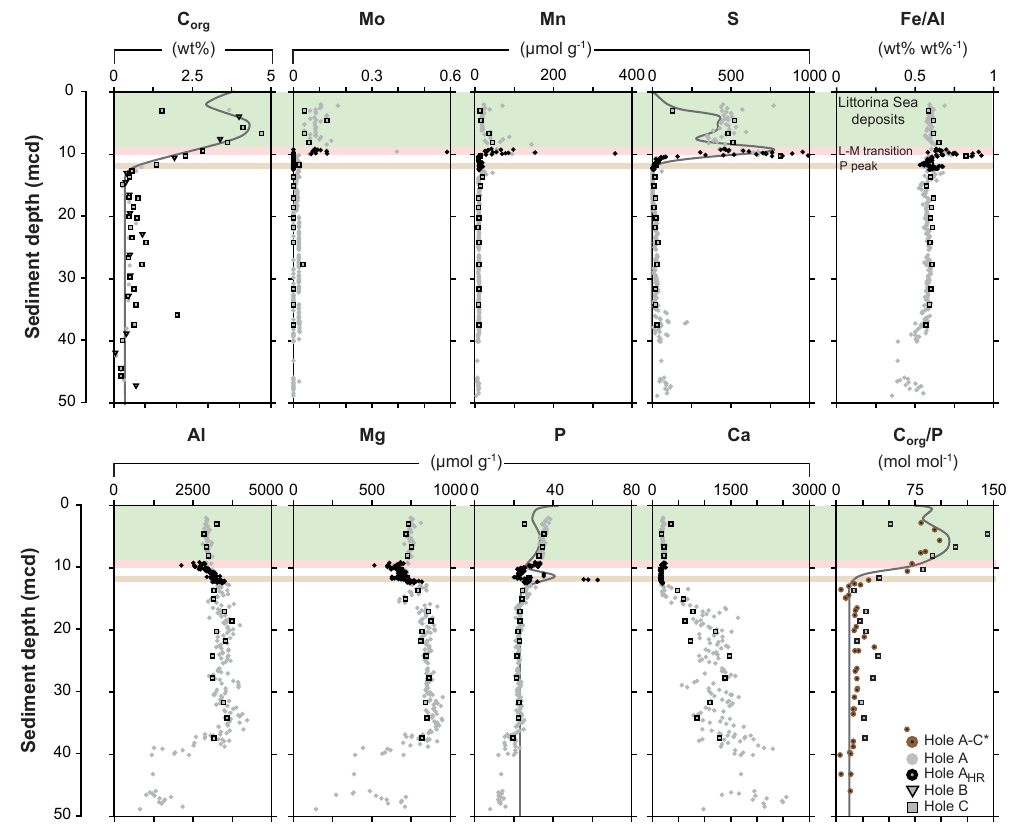
Figure 4. Key elements at station M0065 with sediment depth (solid grey lines: model outputs). More details on the colored areas can be found in the legend of Fig. 3. Hole A HR samples were taken from hole A cores more than 1 year after storage. ∗ The C org / P ratios were calculated using C org contents and estimated values of total P by interpolation between the nearest samples.